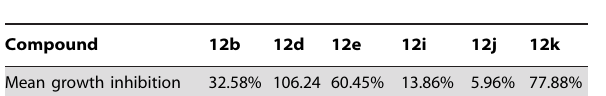
Table 3. Mean growth inhibition of 6 compounds at 10 m m dose (12b, 12d, 12e, 12i, 12j and 12k) while highlighting